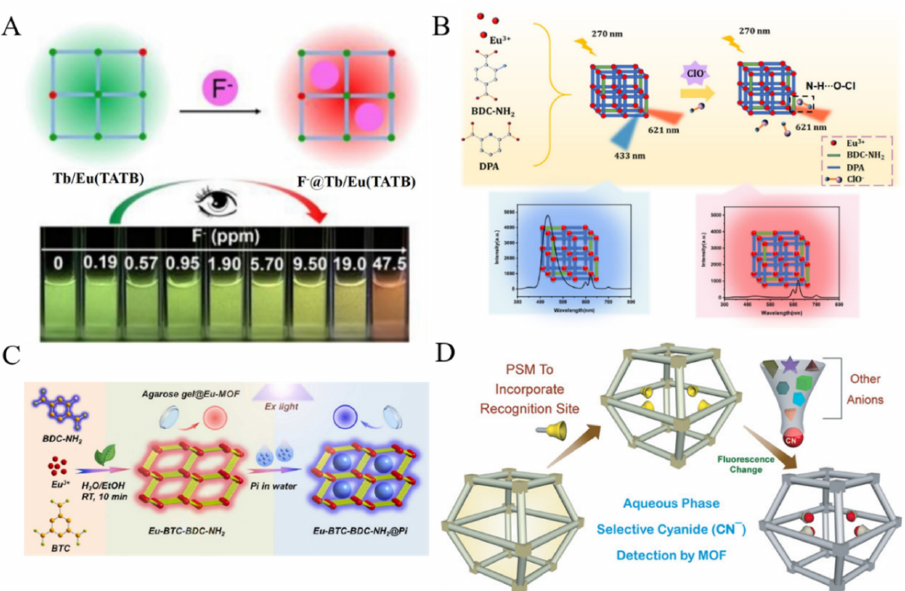
Figure 5. ( A ) Schematic illustration of visual detection of F − using mixed Ln-MOFs with a smart- phone. Reproduced with permission [92]. Copyright 2020, American Chemical Society. ( B ) Schematic illustration of the preparation of Eu-BDC-NH 2 /DPA and fluorescence spectra and photographs in the absence and presence of HClO. Reproduced with permission [95]. Copyright 2021, American Chemical Society. ( C ) Schematic illustration of the detection of PO 4 3 − based on Eu-BTC-BDC-NH 2 . Reproduced with permission [100]. Copyright 2022, Elsevier. ( D ) Schematic illustration of the post-synthetic modification in MOF leading to selective sensing of CN − . Reproduced with